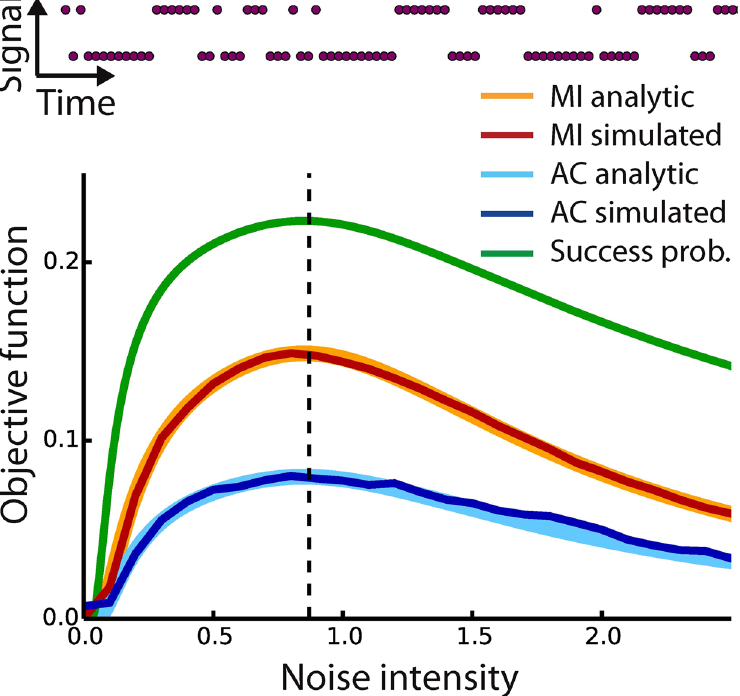
Figure 2. Results of analytical model and numerical simulations. Top: Example of a discrete signal consisting of a correlated bipolar string with p ( s t = s t + 1 ) = 0.7. Bottom: Comparison of different objective functions versus noise intensity for correlated bipolar strings with symmetric threshold and a signal-to-threshold distance of 0.1. Analytical and numerical solutions coincide, and all objectives functions show a maximum at the same noise level. MI = mutual information, AC = autocorrelation of the output